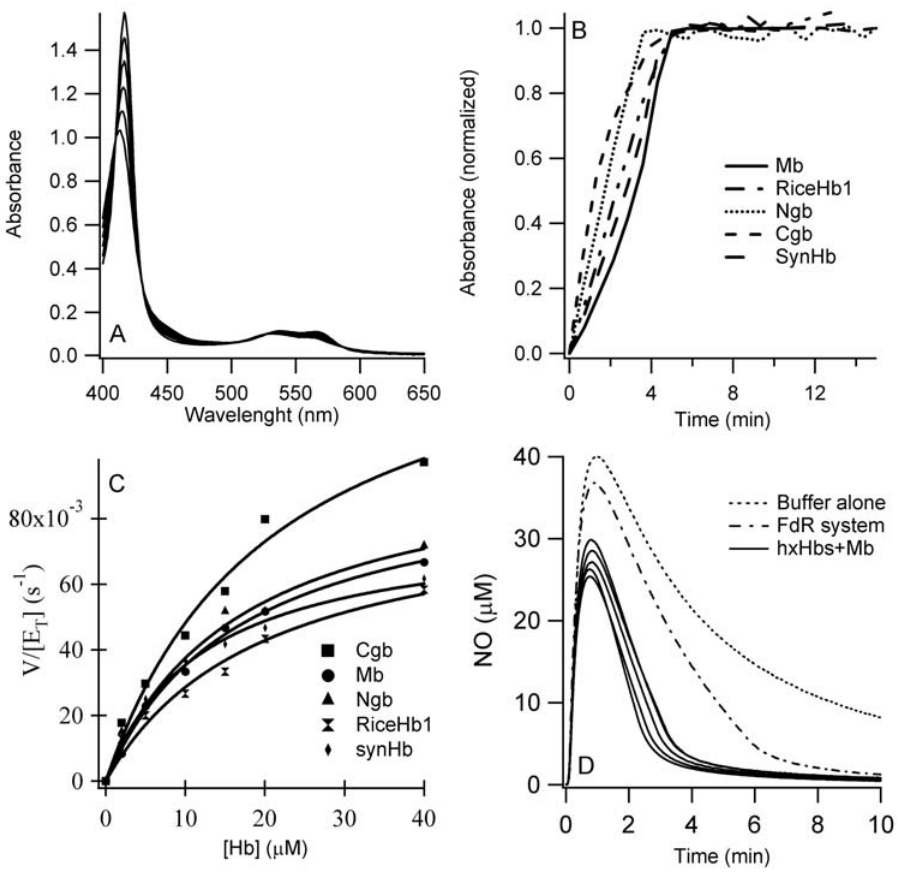
Figure 5. Enzymatic reduction by ferredoxin-NADP reductase and catalytic NO consumption . A. Absorption spectra associated with the reduction of Ngb (10 m M) by 1 m M ferredoxin-NADP reductase in the presence of CO (1 mM). B. Change in absorbance at the Soret peak (CO-bound) associated with the reduction is plotted vs time for each Hb (10 m M). The data are normalized to the absorbance change expected for complete reduction of the Hb in question. C. Enzymatic reduction of Mb and hxHbs by ferredoxin-NADP reductase. V/[E T ] calculated at different Hb concentration is plotted vs [Hb]. The fit to the Michaelis-Menten equation gives Km and Vmax for reduction of each protein. D. Consumption of 40 m M NO by 10 m M oxyHb as measured by an NO electrode, in the presence of ferredoxin-NADP reductase (1 m M). For each protein, after addition of NO, the signal drops by , 10 m M corresponding to stoichiometric NOD. [NO] then decreases linearly indicating catalytic NO destruction. Rates of consumption were calculated from the linear phase of catalytic NO